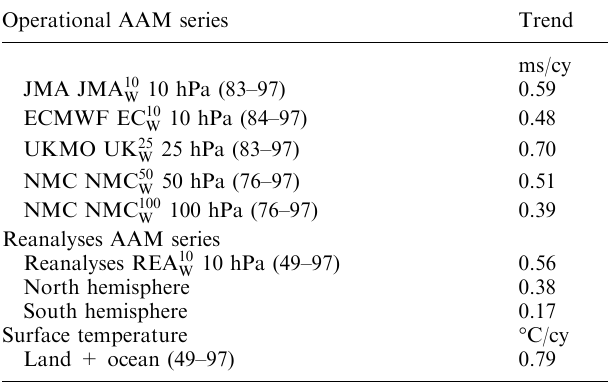
Table 1. Estimates of rates. AAM values are given in 10 ) 3 s (ms) and Temperatures in degrees Celsius ( (cid:176) C). First column gives information on the AAM series; source, name, upper height integrated and length Operational AAM